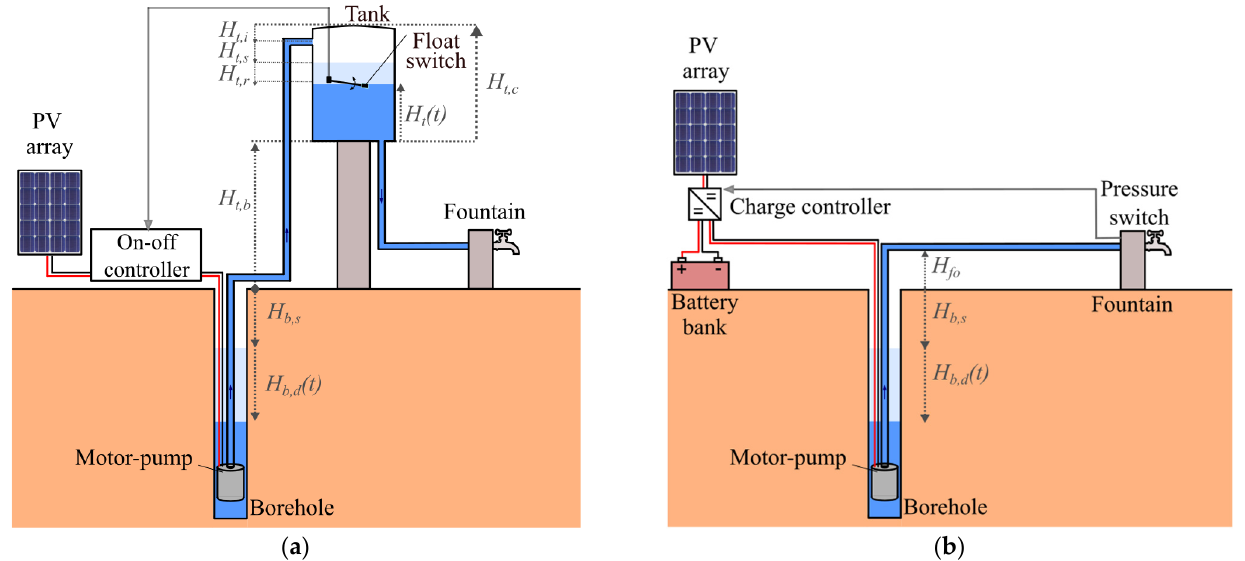
Figure 1. ( a ) Tank PVWPS. ( b ) Battery PVWPS. H t , b : height between the ground level and the bottom of the tank, H t , c : tank height, H t , i (<0): height between the top of the tank and the water entry in the tank, H t , s (<0): height between the water entry and the stop controller level, H t , r (<0): height between the stop controller level and the restart level, H t ( t ) : water level in the tank, H b , s (<0): height between the ground level and the static water level in the borehole, H b , d ( t ) (<0): height between the static level and the water level in the borehole (i.e., the drawdown), H fo : the height between the ground level and the fountain’s tap.